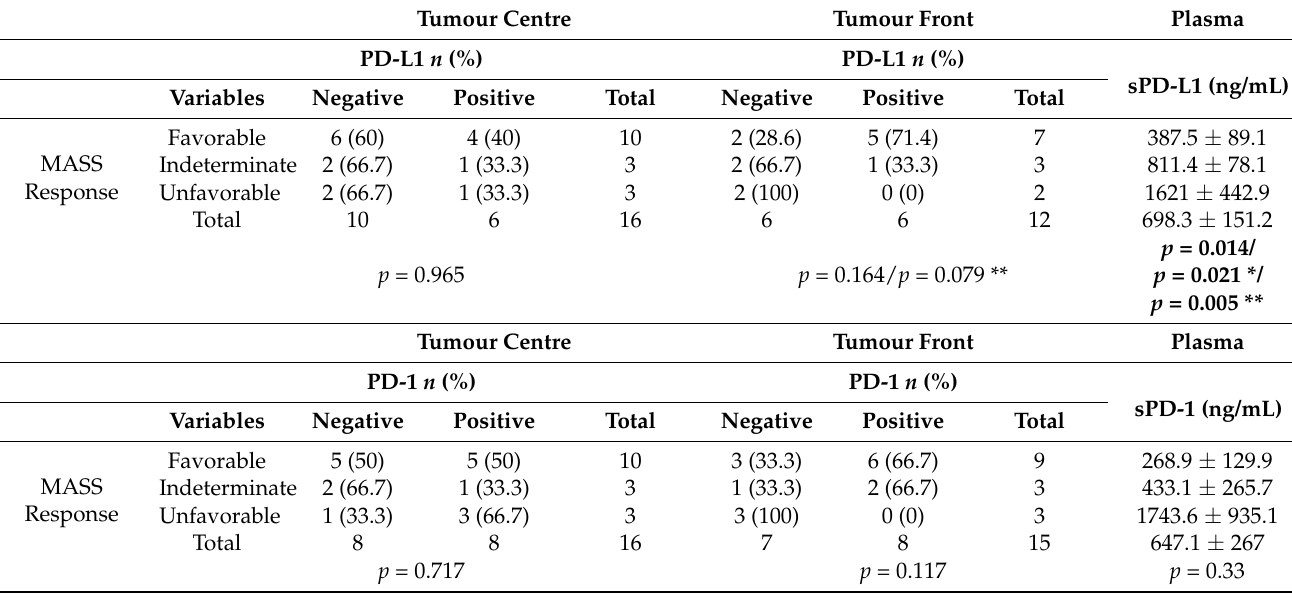
Table 6. PD-L1 and PD-1 expression and sPD-L1 and sPD-1 levels in patients with treated metastatic CCRCC according to Morphology, Attenuation, Size and Structure (MASS) classification of response to therapy (* Favorable and Indeterminate responses pooled together; ** Indeterminate and Unfavorable responses pooled together). Chi-x 2 , Mann-Whitney and Kruskal Wallis tests were used. Statistically significant values are highlighted in